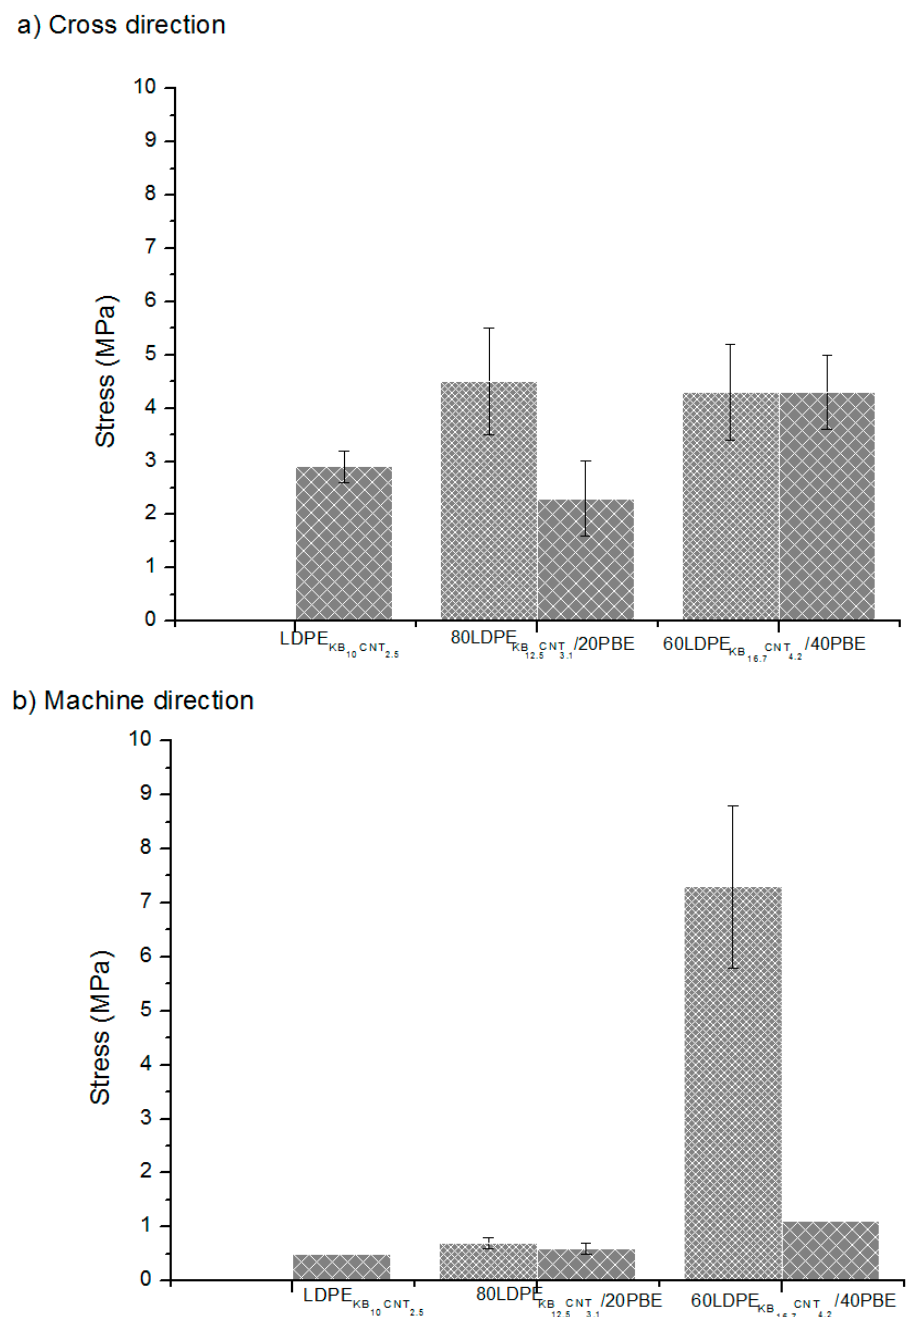
Figure 25. Strain (%) of the conducting biphasic blends produced by a 1-step ( ) or 2-step ( ) extrusion 3D-printed onto textile materials in the cross ( a ) and machine ( b ) directions of the fabric.